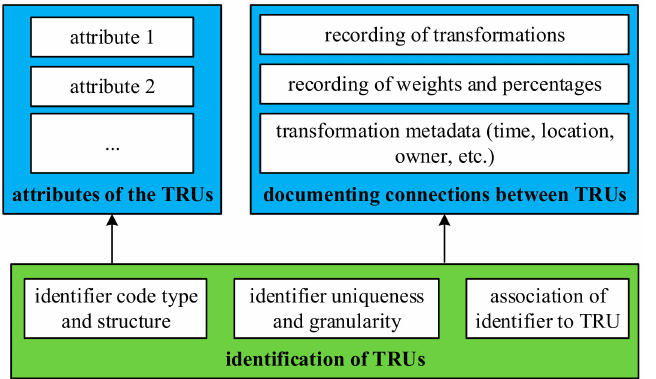
Figure 1. Components of a traceability system. The upper two components, that is, attributes of the TRUs and documenting connections between TRUs, are based on the identification of TRUs. More details are available in